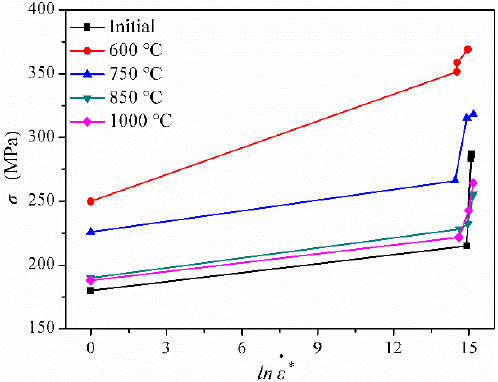
Figure 12. Strain rate effect of FeNiCoCr HEAs annealed at different temperatures.